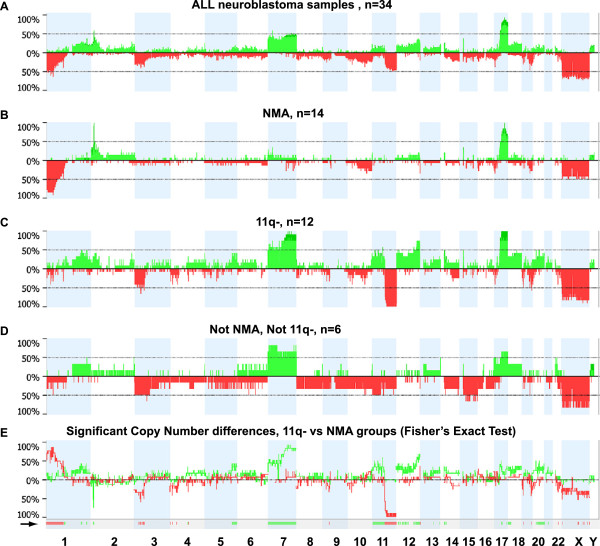
Genetic findings in unfavorable neuroblastoma. The frequency of copy number changes was calculated for all measurement points in the arrays and plotted relative to the position along the chromosome for: (A): all tumors, (B): MNAnot11q- tumors, (C): 11q-notMNA tumors, (D): neither MNA nor 11q loss tumors. The number of analyzed tumors is indicated (n). Green bars above the horizontal line indicate the percentage of tumors with copy gains and red bars below the horizontal line indicate the percentage of tumors with copy losses. Data for the X chromosome were normalized to female reference DNA and the respective proportion of boys in panels A-D were: 56%, 43%, 67%, and 67%, respectively (E): To search for copy number alterations that differ between the11q-notMNA and MNAnot11q- groups, the frequency percentage difference between the two groups are plotted: Copy number gain difference (green graph): Values above baseline represent regions in which gains are more numerous among 11q-not MNA tumors, and vice versa for values below baseline. Deletion difference (red graph): Values above baseline represent regions in which losses are more common among MNAnot11q- tumors, and vice versa for values below baseline. The regions significantly differentially altered between the groups, identified by using Fisher's exact test within Nexus copy-number software, (p<0.05 and threshold difference in frequency >25%), are shown below the graph, as indicated by a black arrow.